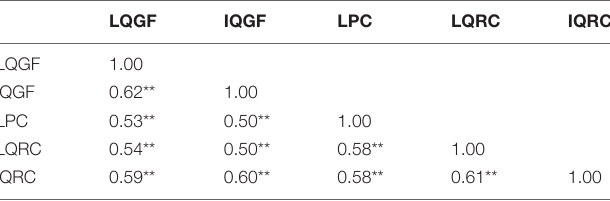
TABLE 3 | Correlation matrix of the reading comprehension